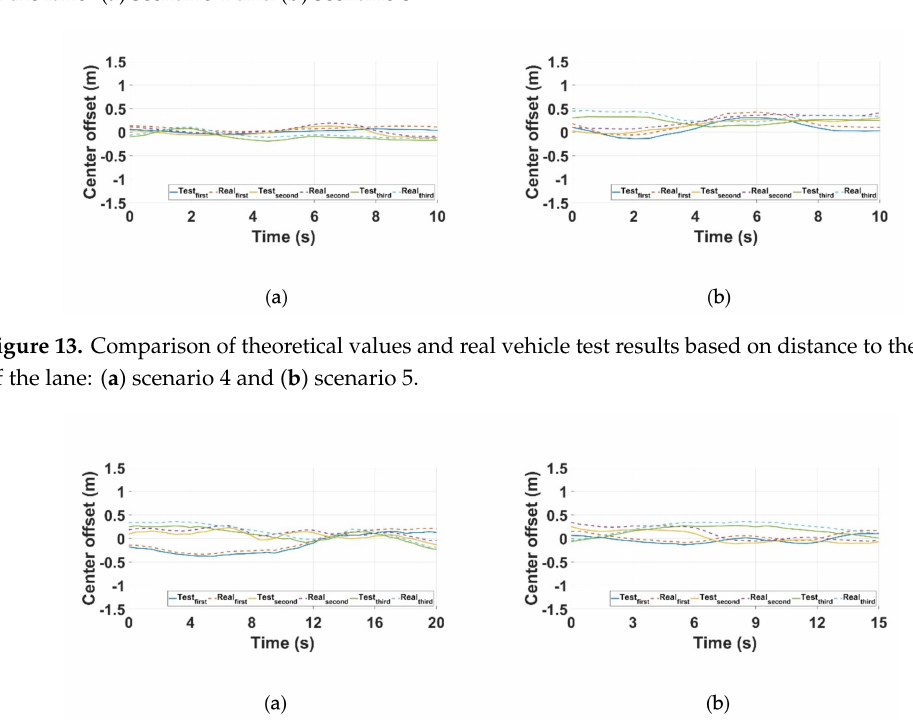
Figure 12. Comparison of theoretical values and real vehicle test results based on distance to the center of the lane: ( a ) scenario 1 and ( b ) scenario 3.